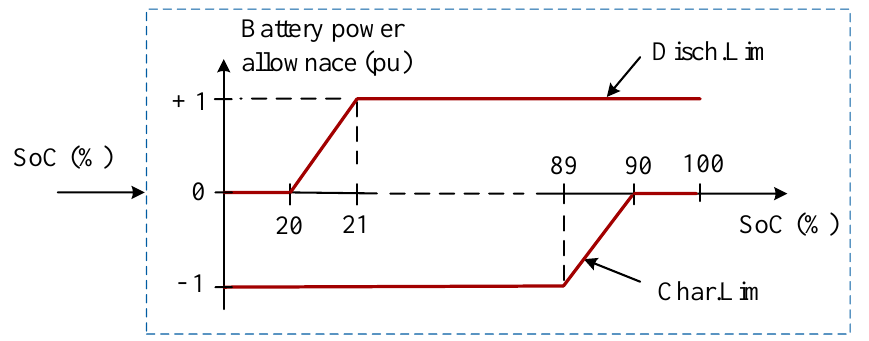
Figure 3. Limits of I d -V d droop for the battery unit.